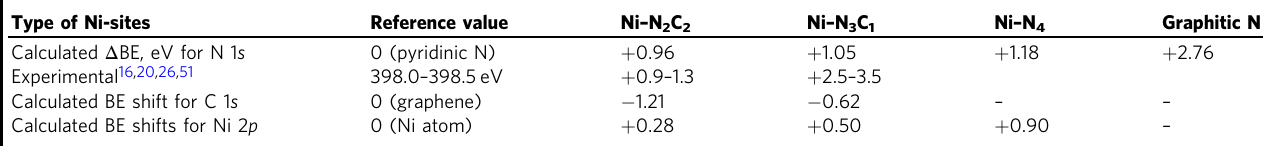
Table 2 QM derived binding energy shift for N 1 s for different bonding sites with nickel. Type of Ni-sites